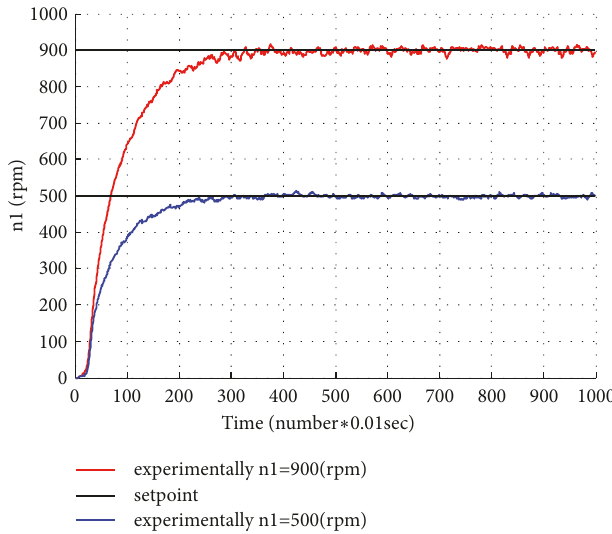
Figure 16: Velocity respone of the working shaft at oil temperature of 50 ∘ C.